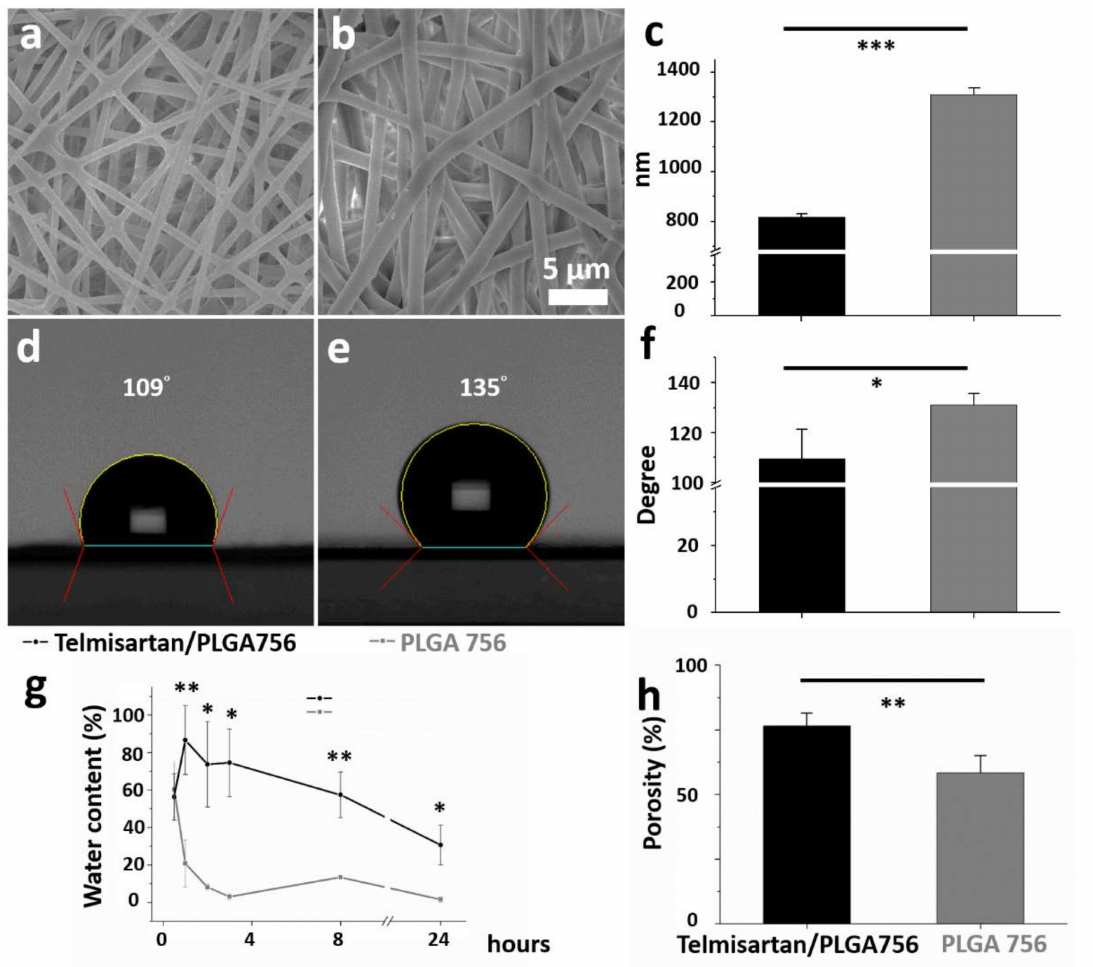
Figure 2. ( a ) Blended nanofibrous membranes of telmisartan/PLGA 756 and ( b ) plain PLGA 756. ( c ) Mean fiber diameters in both nanofiber groups. ( d ) Water contact angles of telmisartan/PLGA 756 and ( e ) plain PLGA 756. ( f ) Mean contact angles in both groups. ( g ) Difference between water contents of two nanofibers after 24 h of PBS immersion and ( h ) their porosities. (*** p < 0.001; ** p < 0.01; * p <